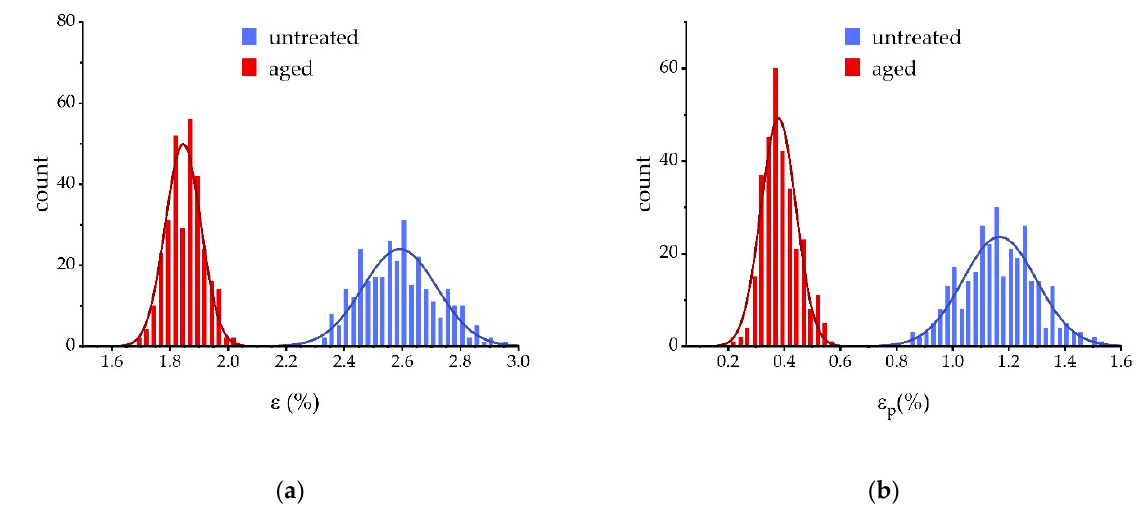
Figure 7. Histograms of ( a ) total strain at break and ( b ) plastic strain at break for Ø3.6C compact steel cord in untreated and 150 °C/45 min aged conditions.